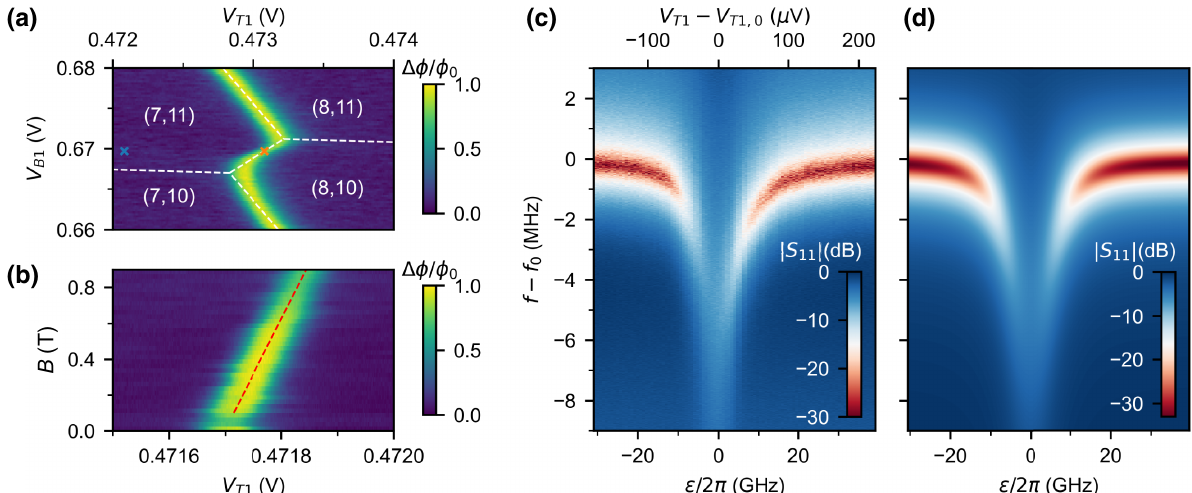
FIG. 2. Resonator-DQD interaction in the dispersive regime. (a) Reduced phase response of the resonator (cid:9)φ/φ 0 around the ( 7, 11 ) ←→ ( 8, 10 ) ICT. Color-coded crosses denote the positions of measurements on and off the ICT, respectively, see Fig. 3(a). (b) Magnetospectroscopy of the ( 7, 11 ) ←→ ( 8, 10 ) ICT, which we use to calculate the interdot gate lever arm. (c) Magnitude of the signal reflected from the cavity showing the shift in the resonant frequency as V T 1 is swept across the ICT. (d) Simulated data, using Eq. (2), to reproduce the experimental data in